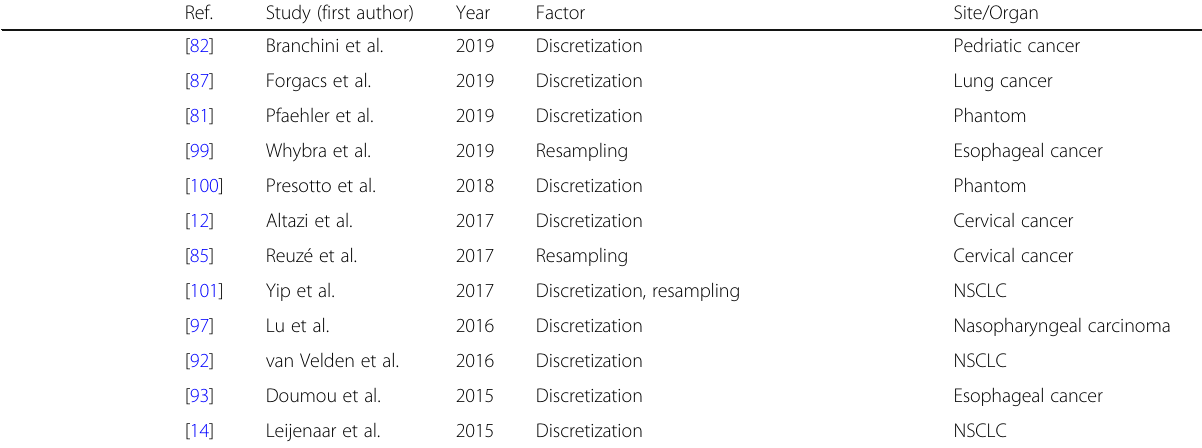
Table 2 Literature review for oncologic imaging or phantom studies with positron emission tomography (Continued)